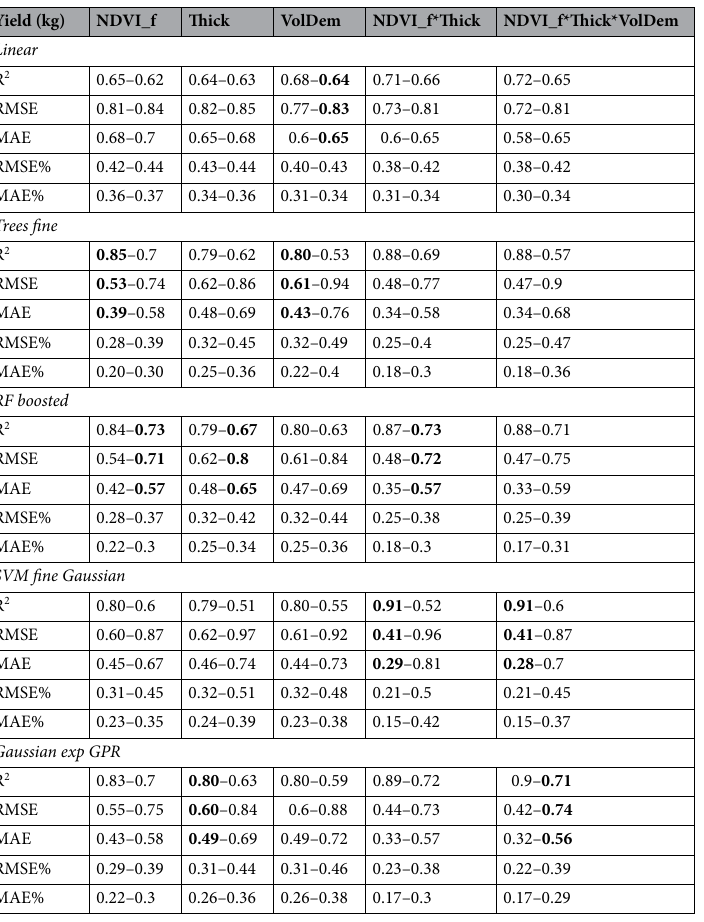
Table 4. Regression models performance (R 2 , RMSE, MAE, RMSE%, MAE%) obtained from the complete dataset (2017–2018-2019) between yield and NDVI filtered (NDVI_f), canopy thickness (Thick), canopy volume (VolDem), NDVI filtered and canopy thickness (NDVI_f Thick), NDVI filtered, canopy thickness and canopy volume (NDVI_f Thick VolDem). Each cell presents 2 values, the first calculated without cross validation, and the second using fivefold cross validation. The best resulting models are bold